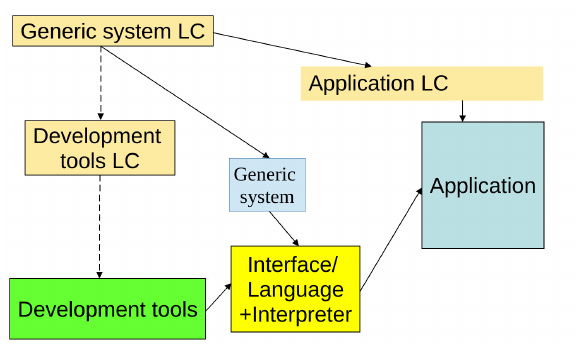
Figure 1. The example of lifecycle hierarchy of com- plex